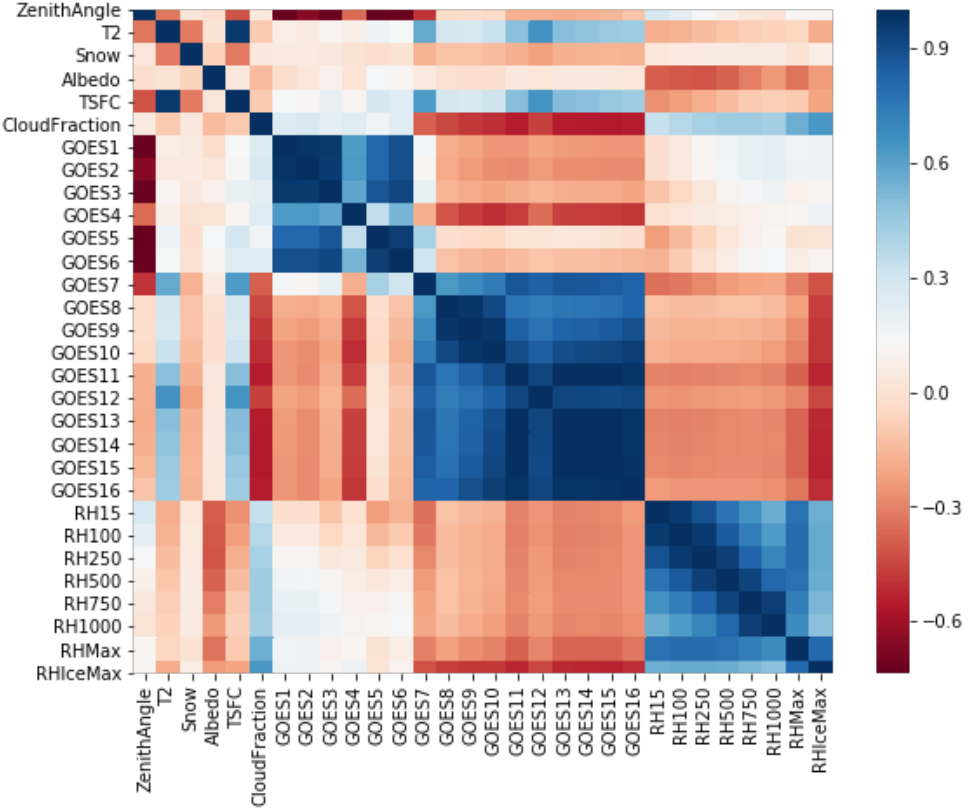
Figure 3. Correlation matrix for all predictors and predictand (Cloud Fraction) indicating there is multicollinearity in the range of Geostationary Operational Environmental Satellites (GOES) 1 through 6, GOES 7 through 16, and all relative humidity (RH)